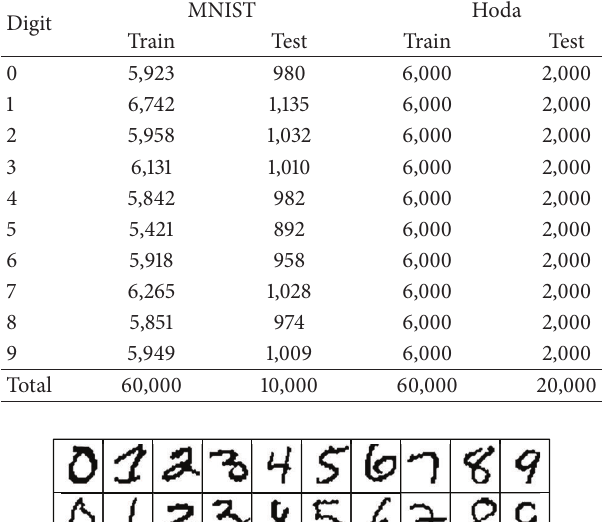
Table 3: Distribution of digits in the MNIST and Hoda datasets.